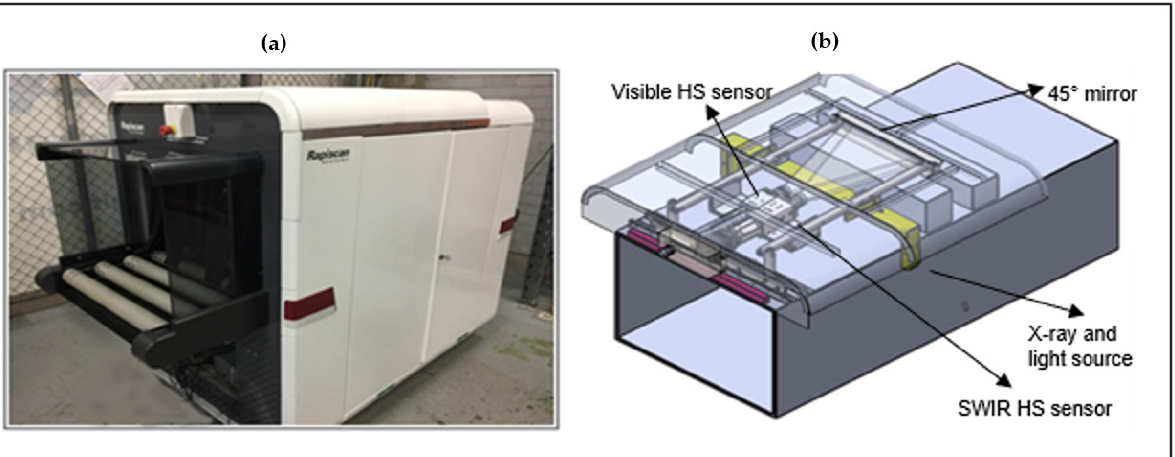
Figure 1. Rapiscan multi-sensory imaging system used to scan livestock parenchymatous organs. ( a ) The external view of the complete prototype imaging system (AK198); and ( b ) A schematic showing placement of the hyperspectral cameras within the imaging system. Source: Rapiscan Systems Pte Ltd., Singapore.